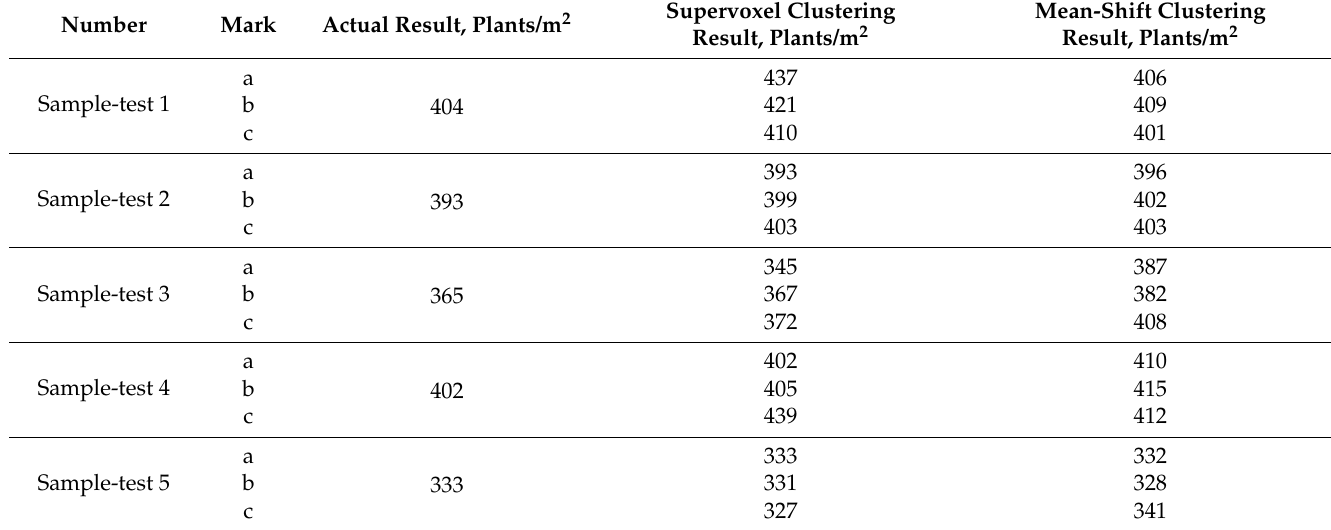
Table 5. Rice-density estimation of random experiment